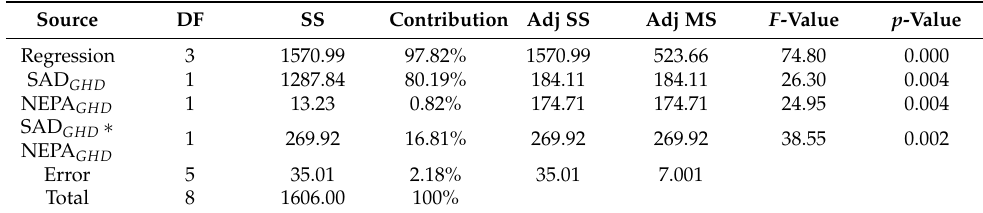
Table 8. ANOVA results for the Get hot drink PLSR model.